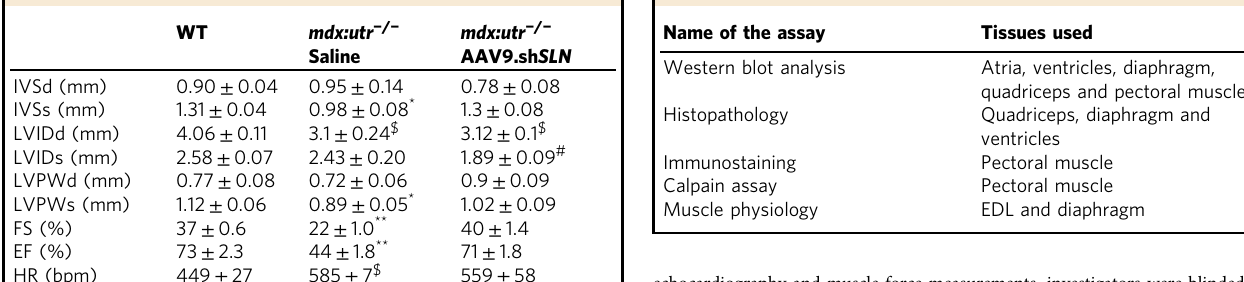
Table 3 Tissues used for various